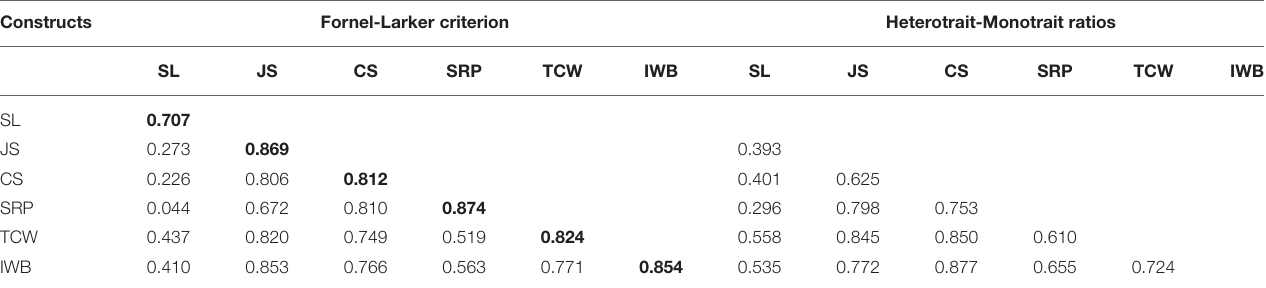
TABLE 2 | Discriminant validity. Constructs